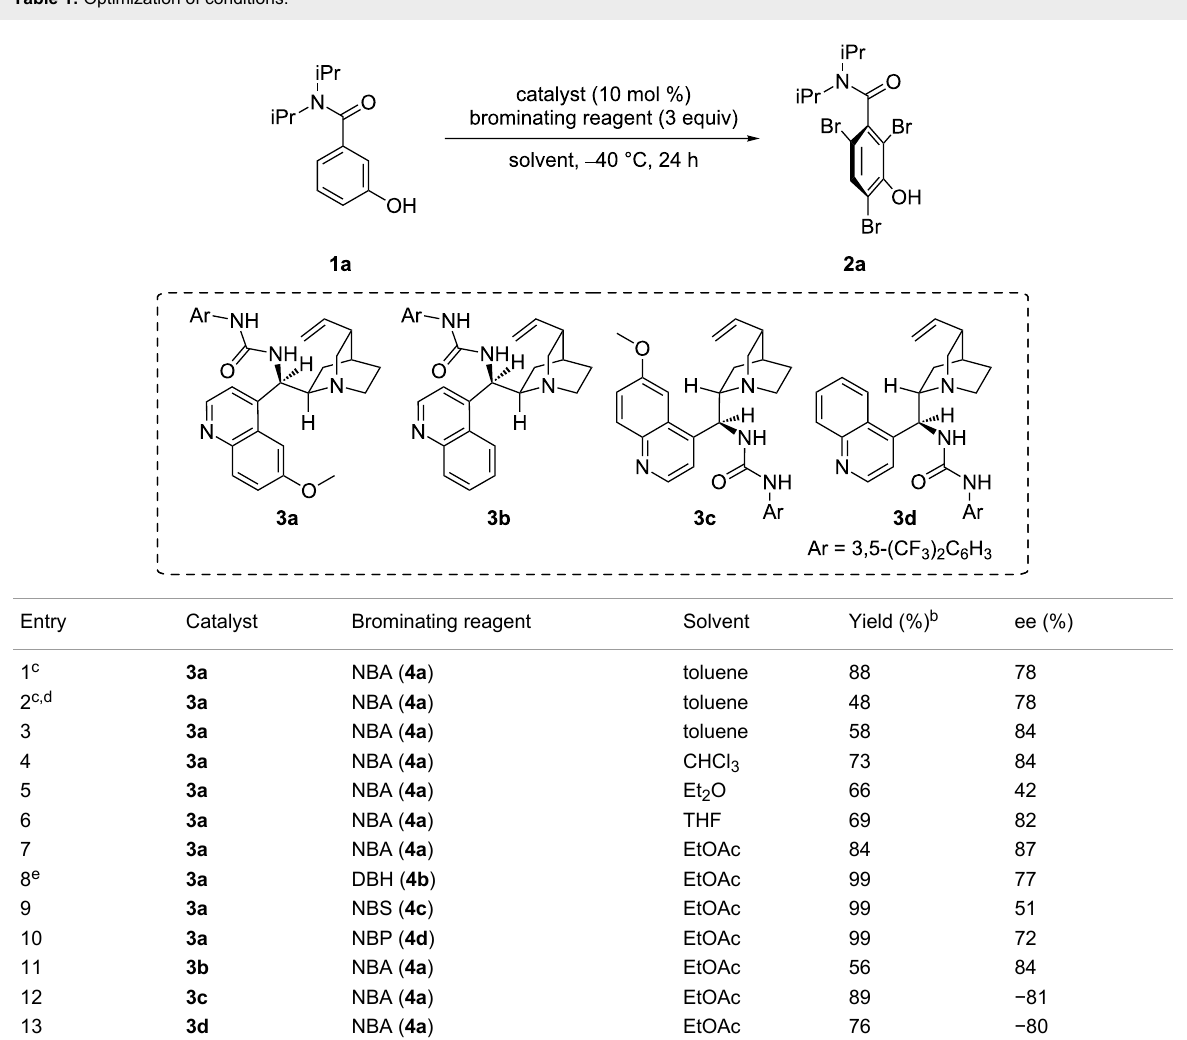
Table 1: Optimization of conditions.